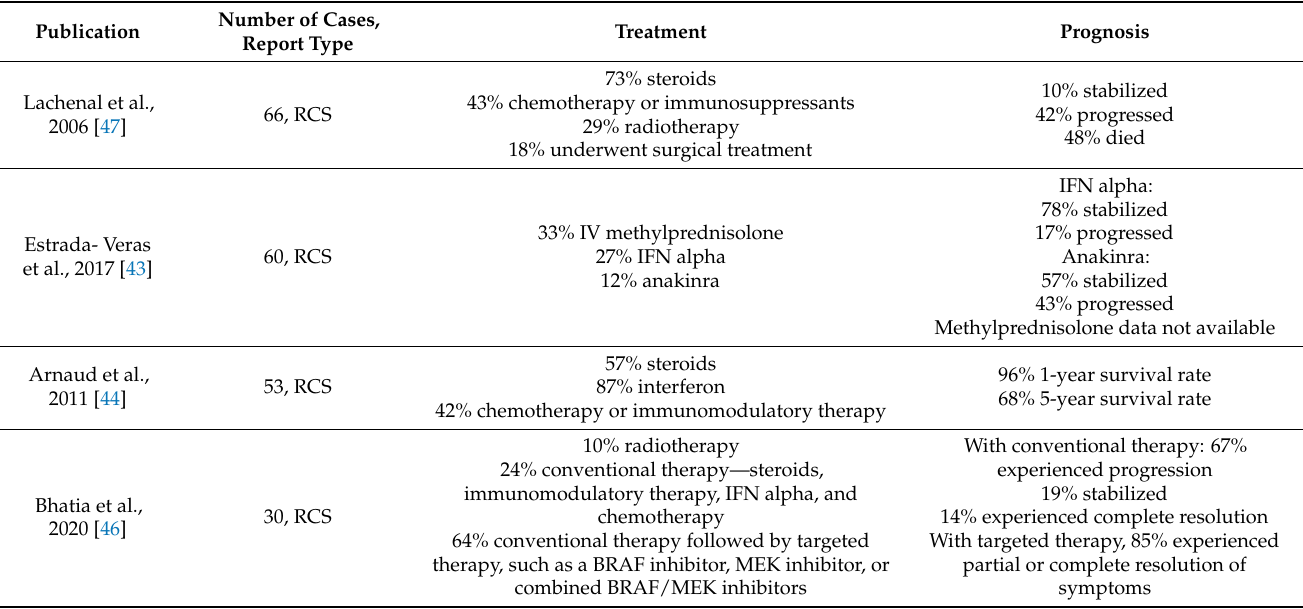
Table 6. Treatment and prognosis of ECD patients involving CNS, as reported in the following retrospective studies in the